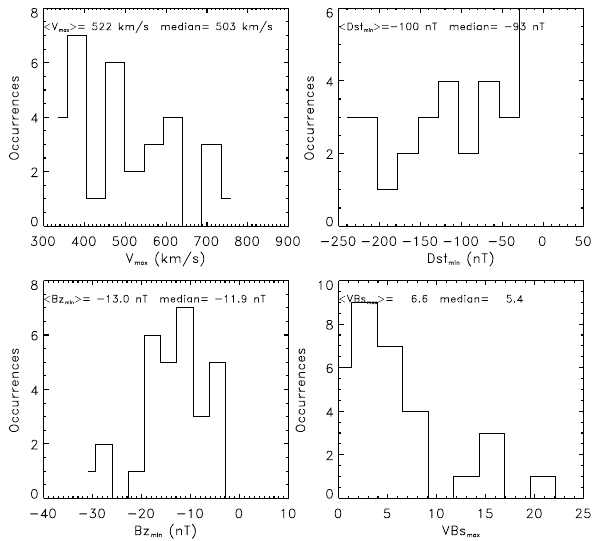
Fig. 5. Histograms of V max , D st